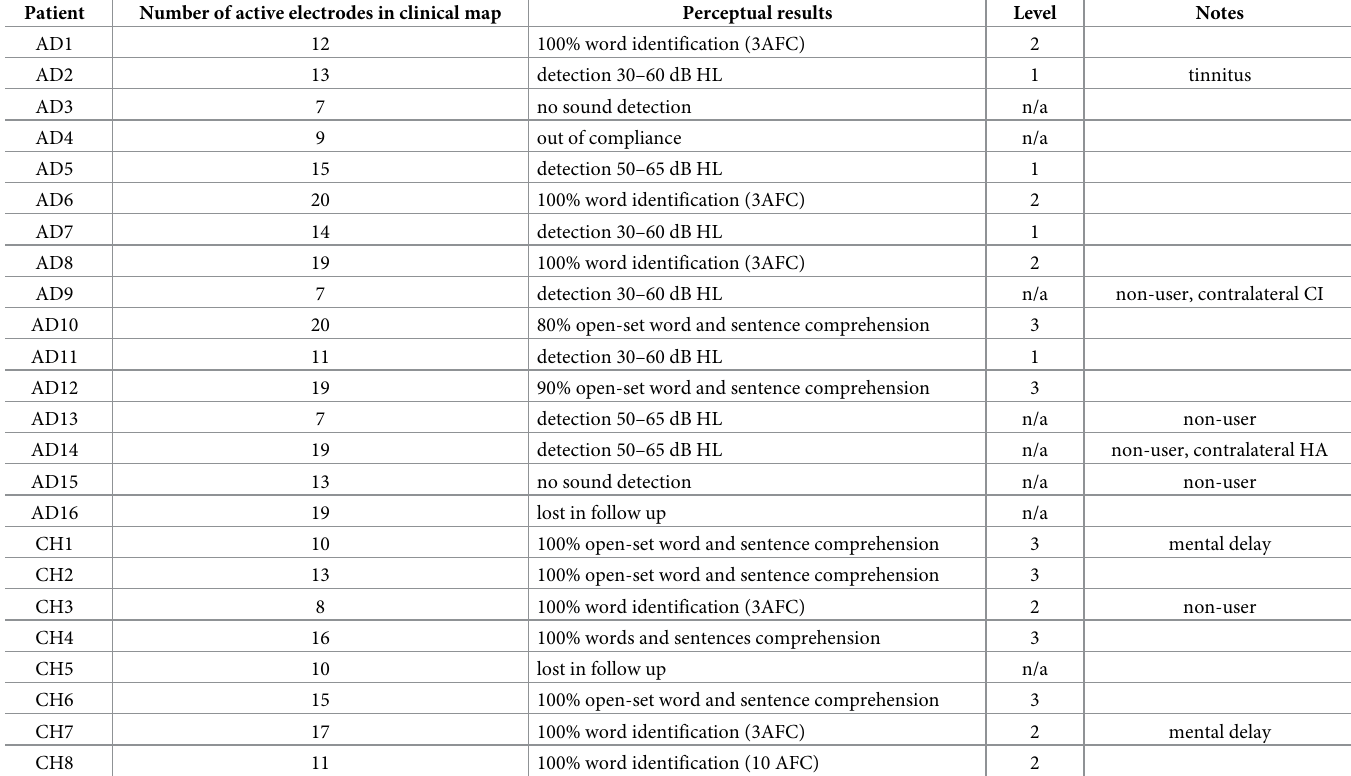
Table 4. Number of viable electrodes estimated from EABRS and at ABI activation, as well as perceptual results. Patient